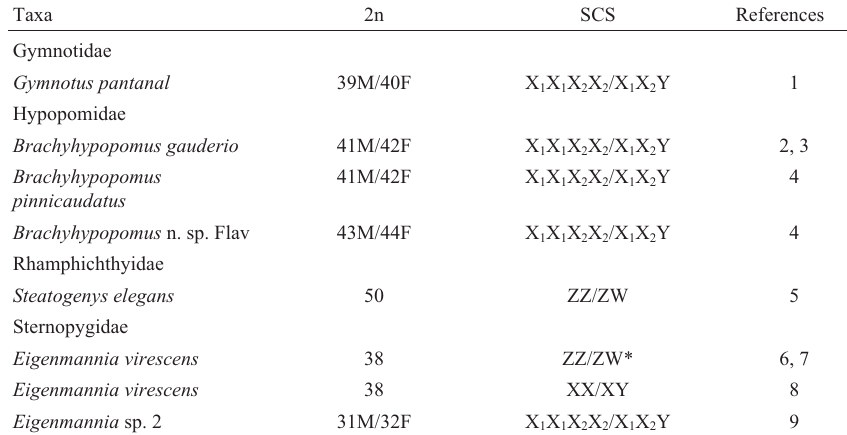
Table 1 - Sex chromosome systems in the Order